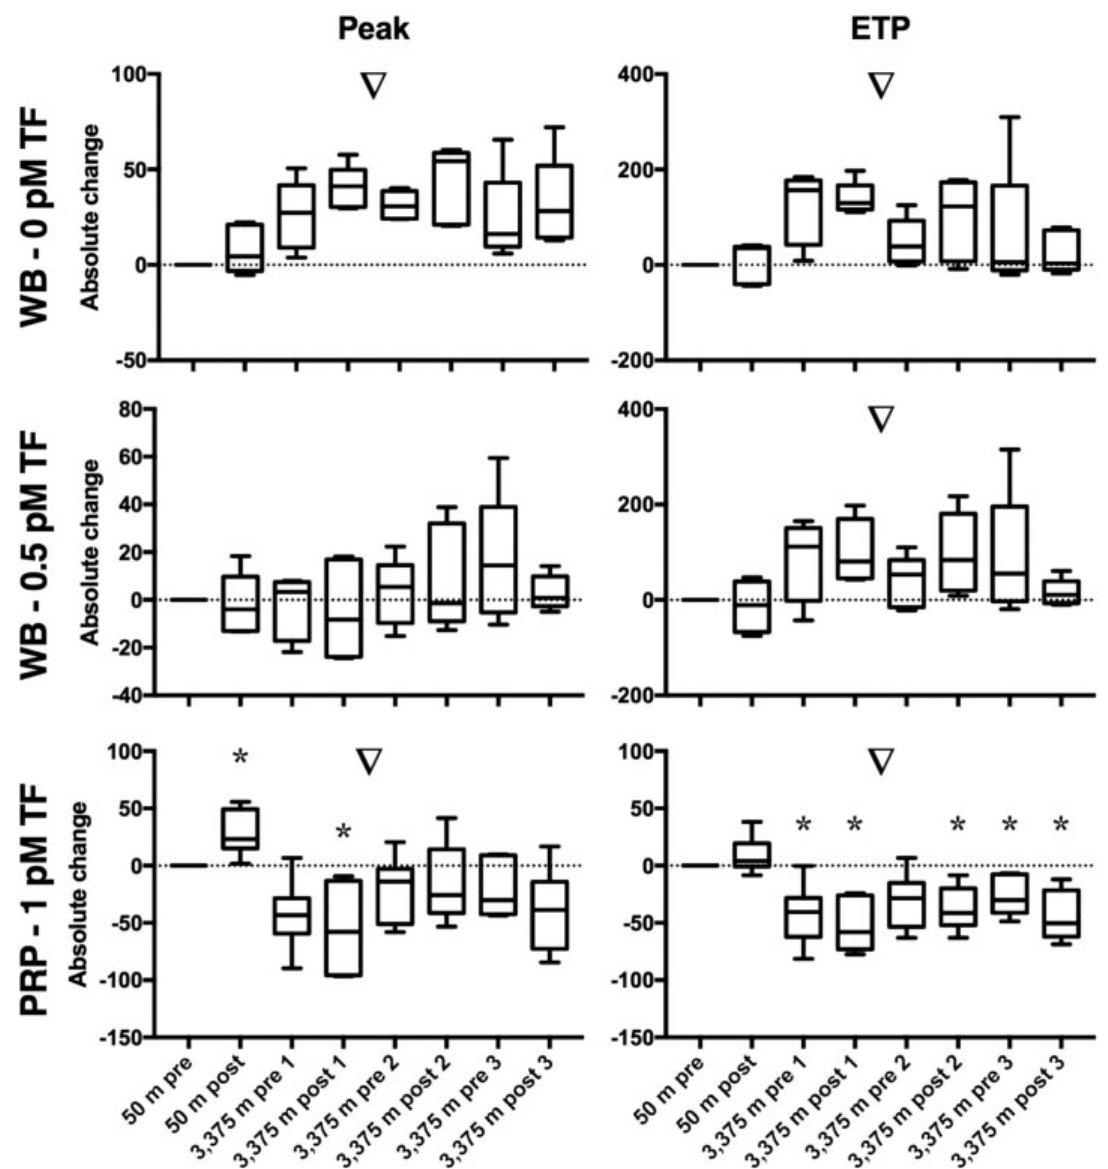
Fig. 3 In fl uence of normoxic and hypoxic exercises on thrombin generation (TG) in whole blood (WB) and platelet-rich plasma (PRP). TG was measured before and after 2 hours of strenuous exercise, once at 50m altitude and three times at 3,375m altitude, in whole blood (WB) and PRP. Parameters derived from the TG curve are peak height (peak in nM or % of NPP) and endogenous thrombin potential (ETP in nM·min or % of NPP). N ¼ 6, one measurementismissing(subject5,WBTGpost3).Resultsareexpressedastheabsolutechangeof50mpre-exercise;avalueabove0indicatesanincrease, and a value below 0 indicates a decrease. 5 ¼ p < 0.05 (Friedman ’ s test); (cid:5) ¼ p < 0.05 compared with zero (Wilcoxon signed-rank test).